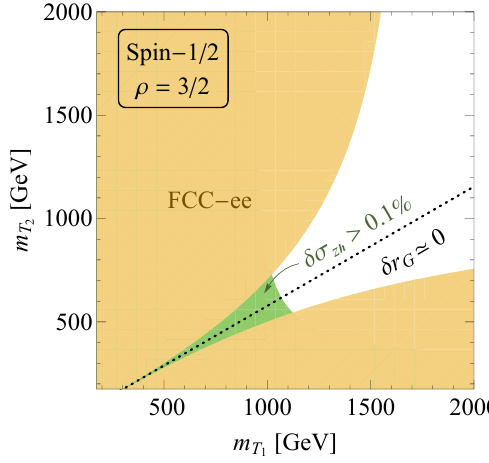
Figure 12 . Expected sensitivities at the 2 (cid:27) C.L. of FCC-ee for two spin-1/2 top-partner model with additional constraints from (cid:14)(cid:27) Zh . The projected sensitivity from FCC-ee is taken from (cid:12)g- ure